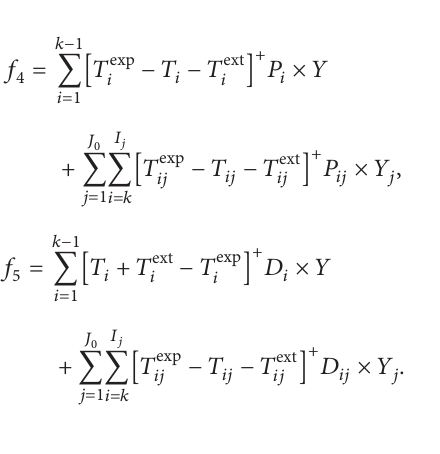
Figure 3: Sequence of events in the time scheduling of the